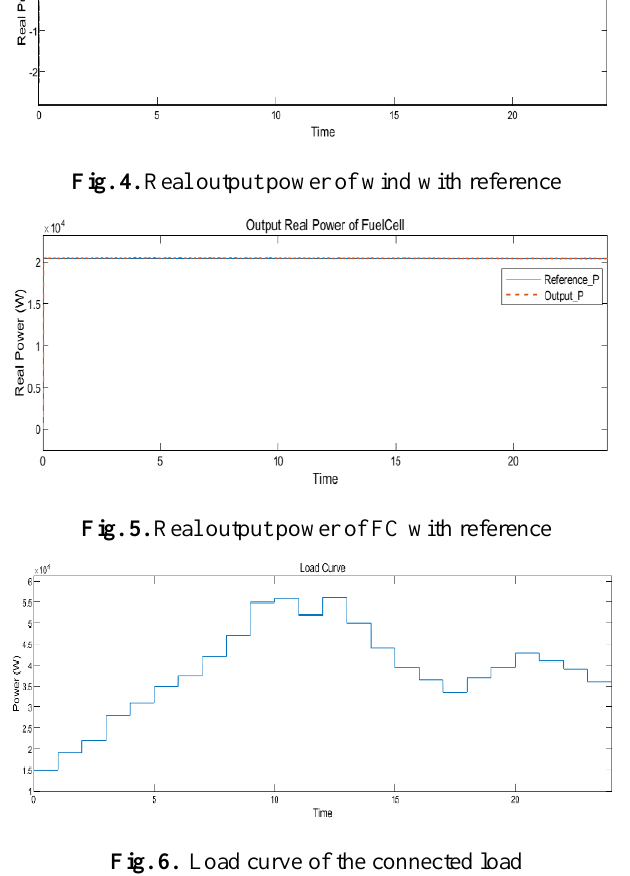
Fig. 6. Load curve of the connected load